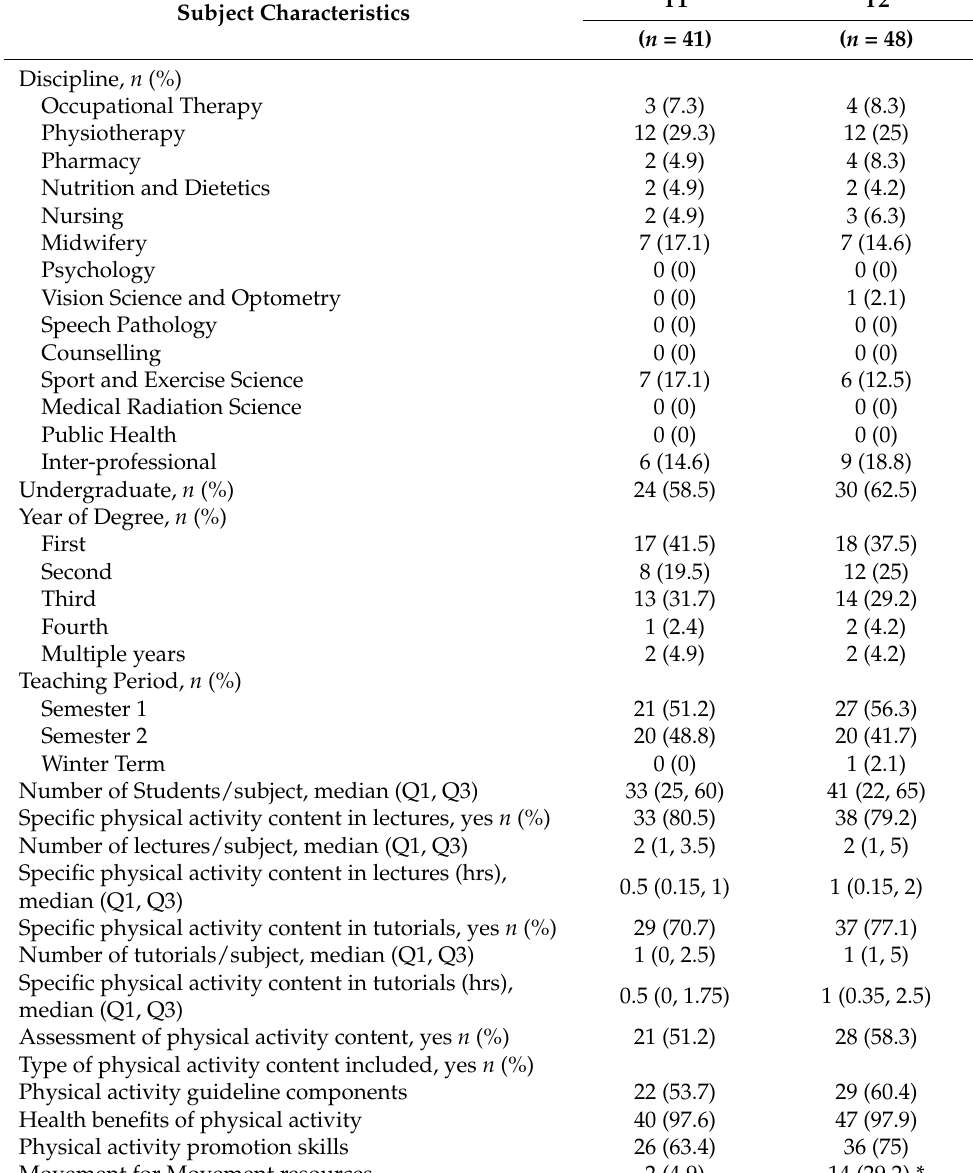
Table 4. Characteristics of subjects containing physical activity content pre- and